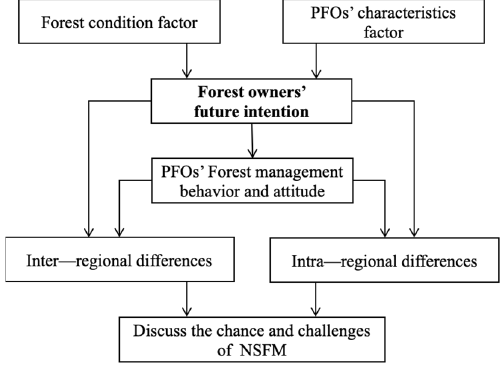
Figure 3. Research structure.